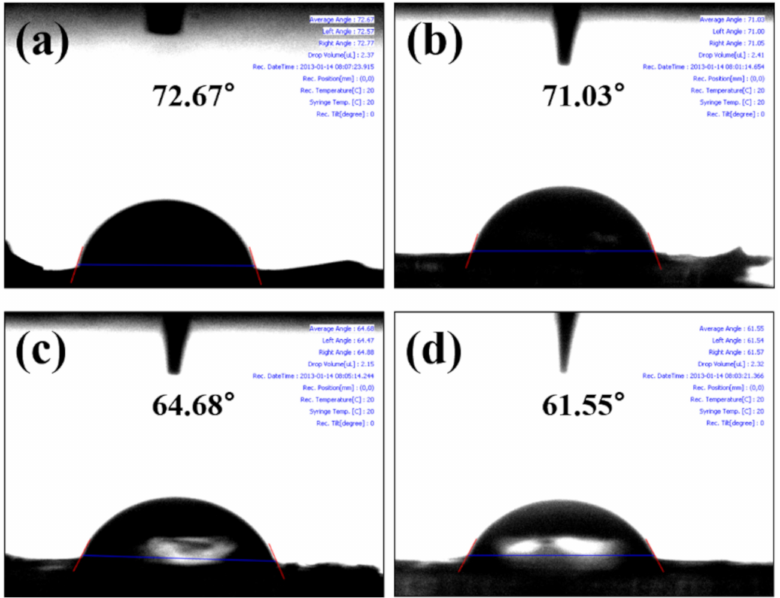
Figure 9. Water contact angle of ( a ) SPAE(pristine), ( b ) SPAE/GO, ( c ) SPAE/GO/PWA 12 wt%, and ( d ) SPAE/GO/PWA 36